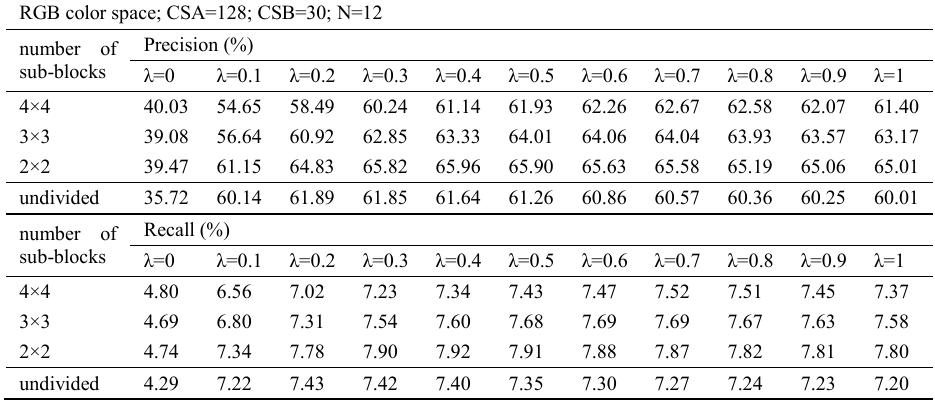
Table 4. Average retrieval precision and recall of different λ and different numbers of sub